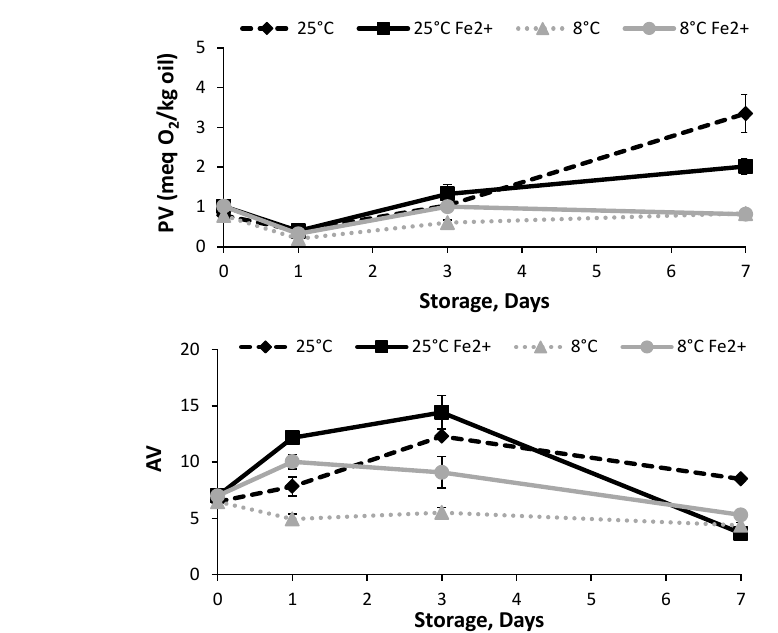
Figure 4. Peroxide value (PV) ( a ) and anisidine value (AV) ( b ) of primary emulsions in a seven day-storage period at 25 °C and 8 °C in the dark.